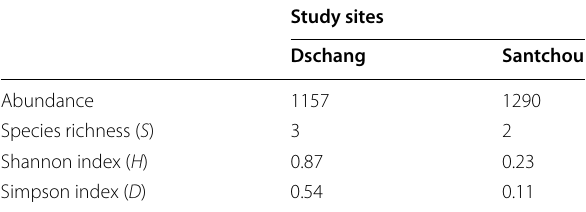
Table 5 Abundance and diversity of Culex mosquitoes in